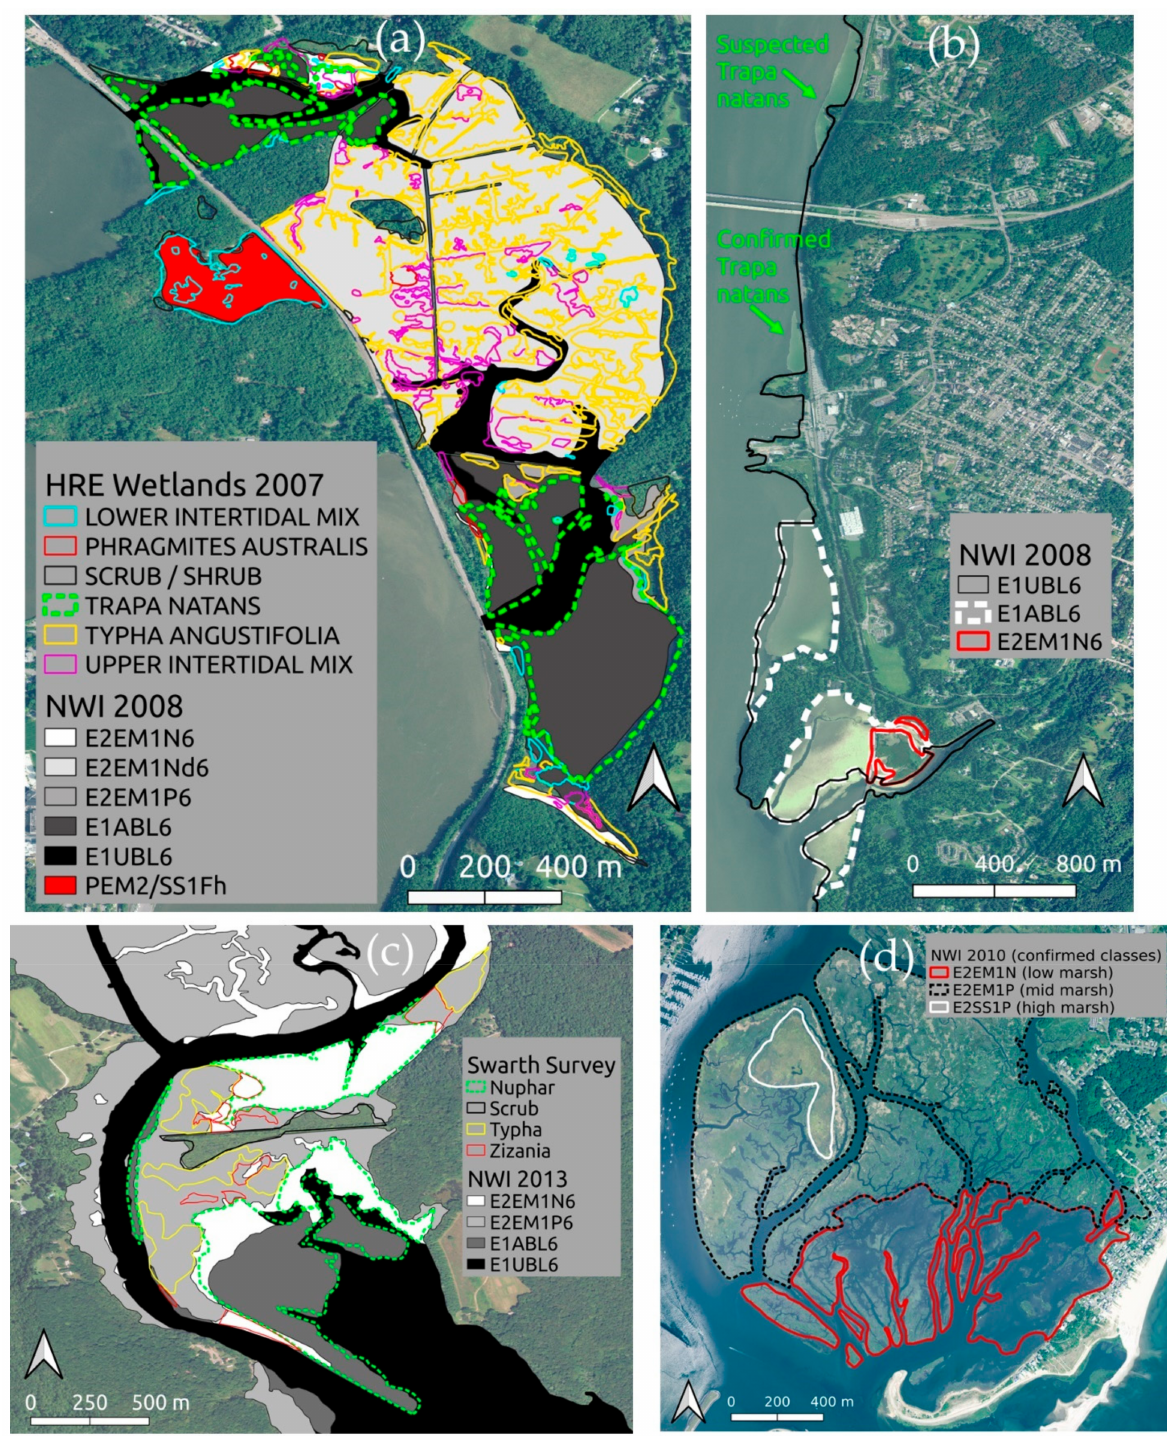
Figure 2. Intensive study sites with final wetland vegetation inventory datasets; Constitution Marsh ( a ), Beacon Bridge wetlands (not an official name) ( b ), Wheeler Marsh ( c ), and Jug Bay ( d ). Wheeler Marsh ground-confirmed classes are shown in legend parentheses. Note there are several cases where NWI classifications do not match more detailed wetland inventories or ground surveys. Detailed descriptions of NWI wetlands codes are provided in Table